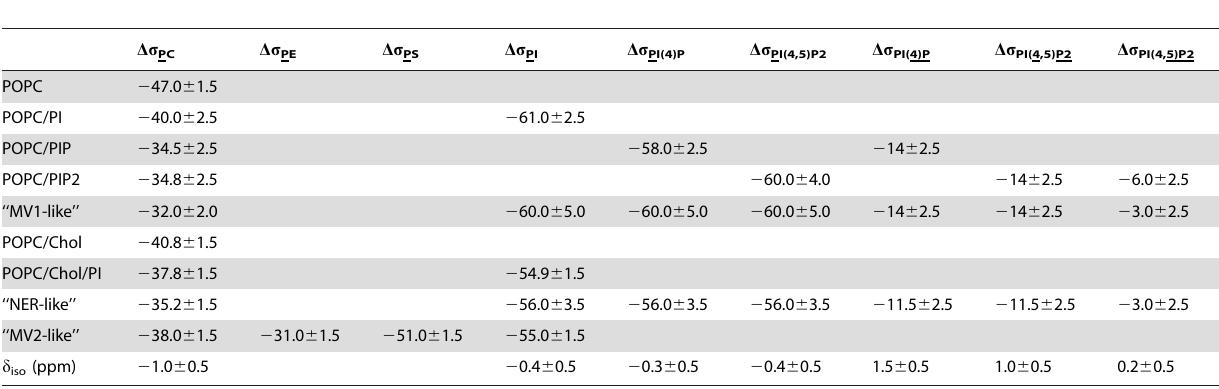
Table 3. Chemical shielding anisotropies, Ds , and isotropic chemical shifts d iso obtained from spectral simulations of experimental spectra of Figure